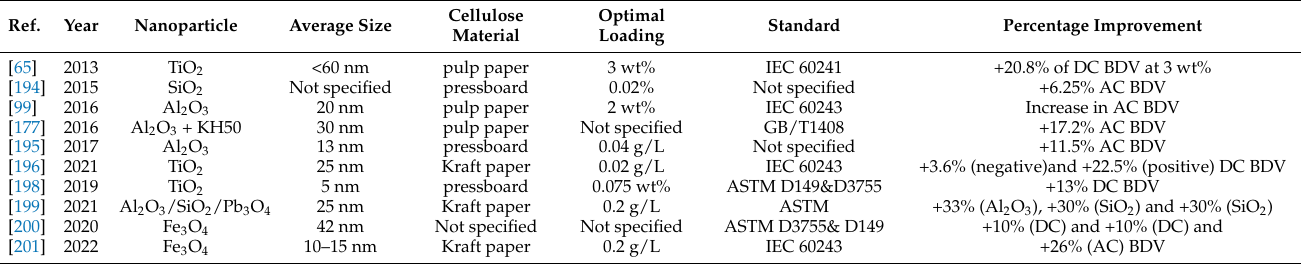
Table 4. Summary of breakdown strength of cellulose paper impregnated in